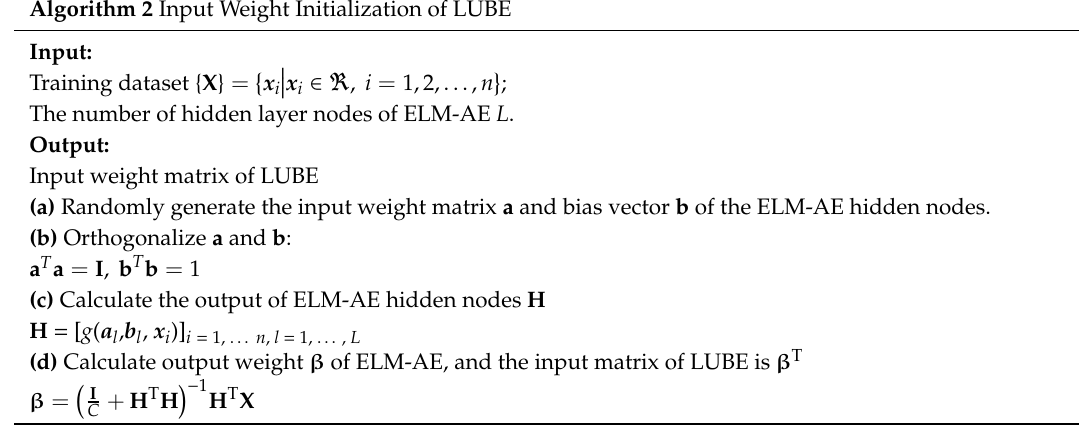
Algorithm 2 Input Weight Initialization of